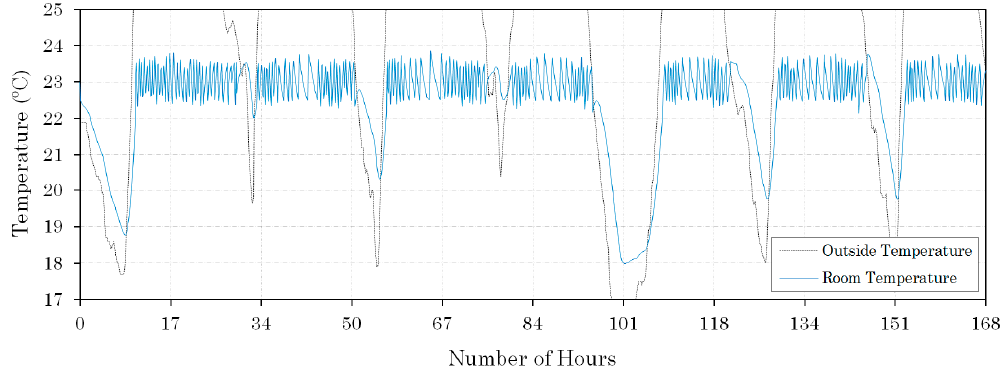
Figure 10. The temperature of the room by using PID (proportional-integral-derivative) control option.